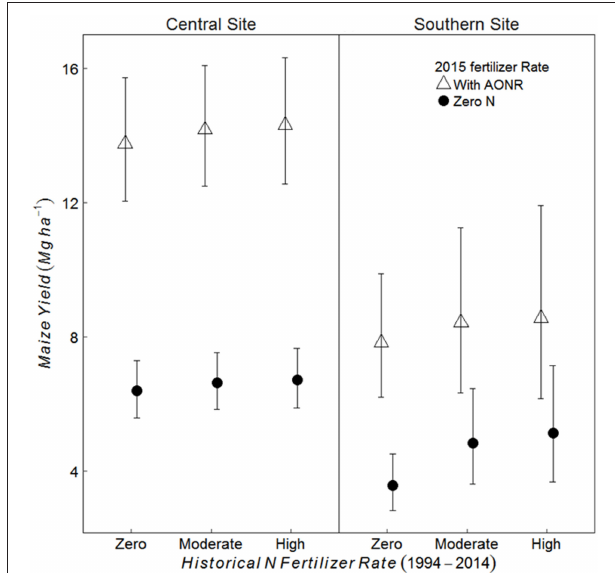
FIGURE 2 | Mean maize yield (Mg grain ha − 1 ) in continuous maize system for three historical N rates of zero, moderate (202 and 224kg N ha − 1 yr − 1 for central and southern sites, respectively) and highest rate (269kg N ha − 1 yr − 1 ), applied with agronomic optimum N Rate (AONR) and zero N fertilizer in 2015 at central and southern Iowa sites. Vertical bars represent 95% confidence intervals.